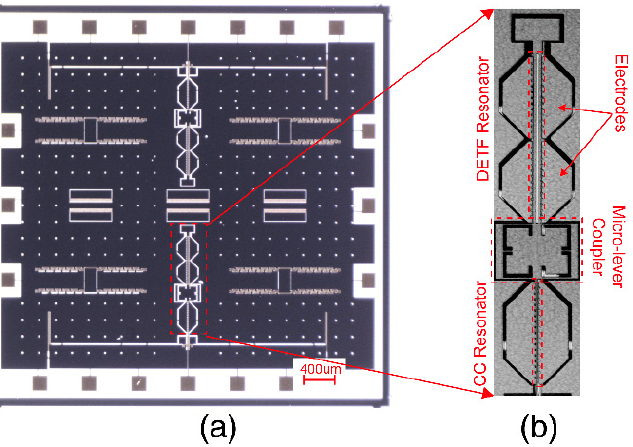
Figure 9. The optical micrographs of the mode-localized accelerometer: ( a ) overview of the mode- localized accelerometer; ( b ) details of the DETF resonator, CC resonator, and micro-lever coupler.